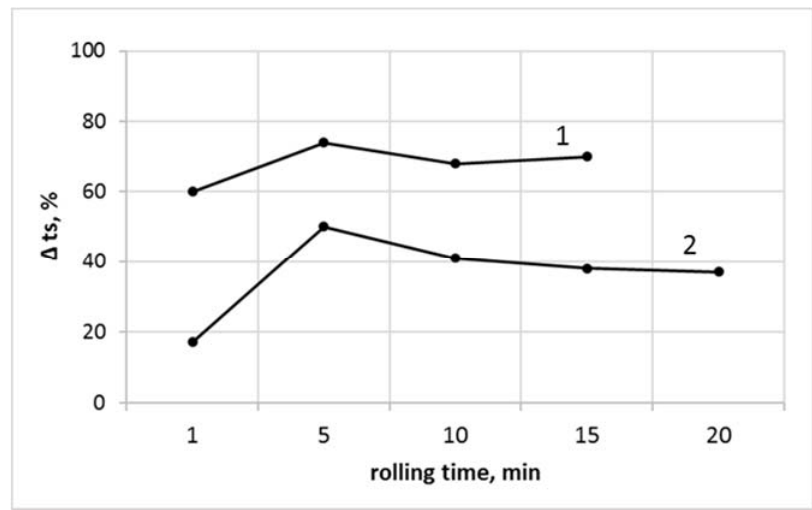
Figure 7. The relative changes of thermal stability of SiO 2 -modified PVC vs. unmodified PVC, as a function of rolling time: (1) PVC C /SiO 2 vs. PVC C ; (2) PVC R /SiO 2 vs. PVC R .